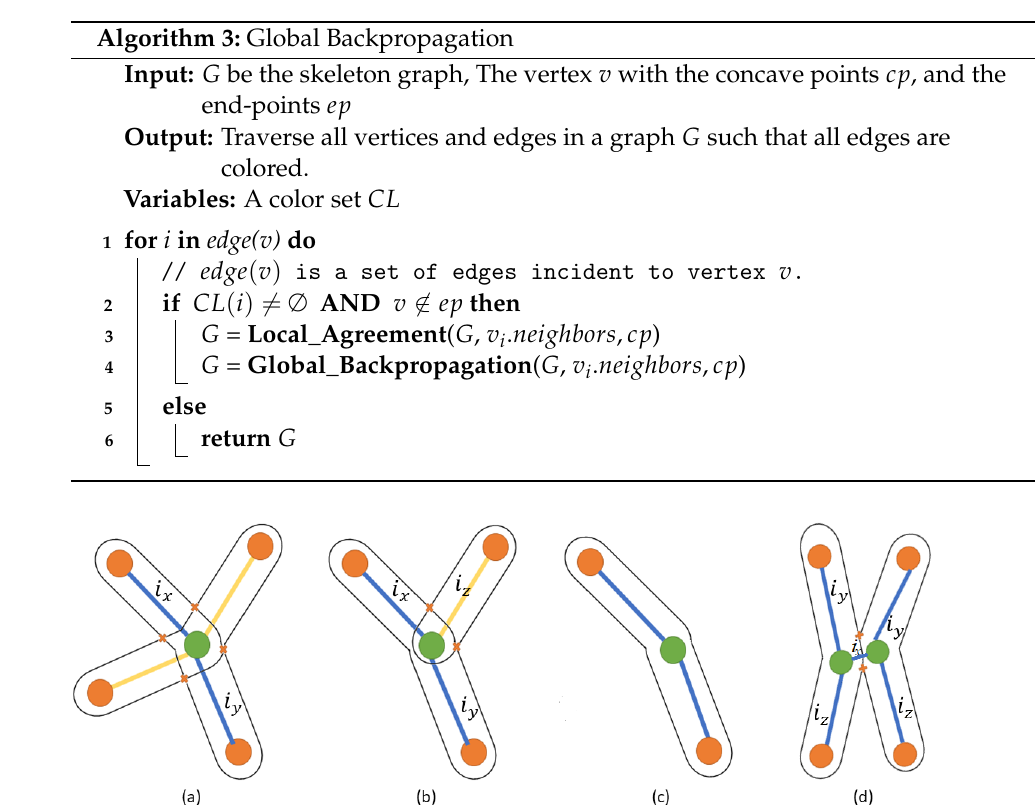
Algorithm 3: Global Backpropagation